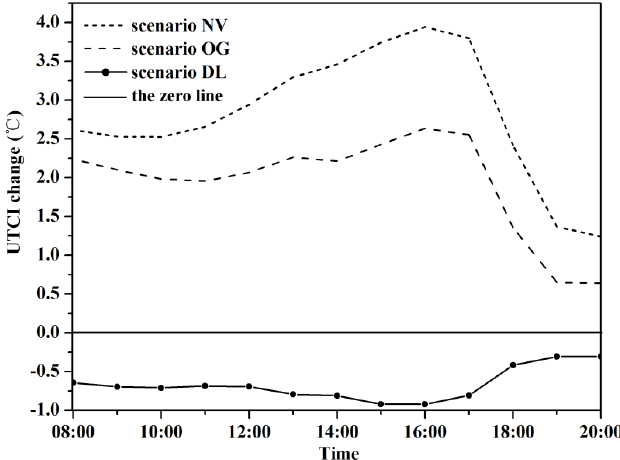
Figure 9. UTCI differences of greening modification scenarios from the base case. NV, OG and DL are short for No Vegetation, Only Grass and Double LAD, respectively.